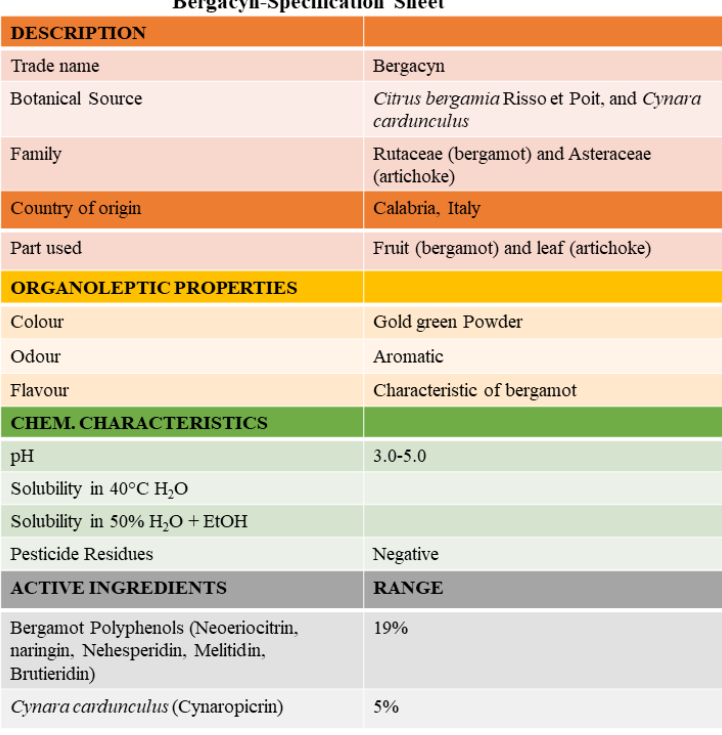
Figure 4. Datasheet of Bergacyn. This table shows the description, the organoleptic and chemical characteristics and the composition of Bergacyn. This data was provided by HEAD srl (Bianco, Italy).